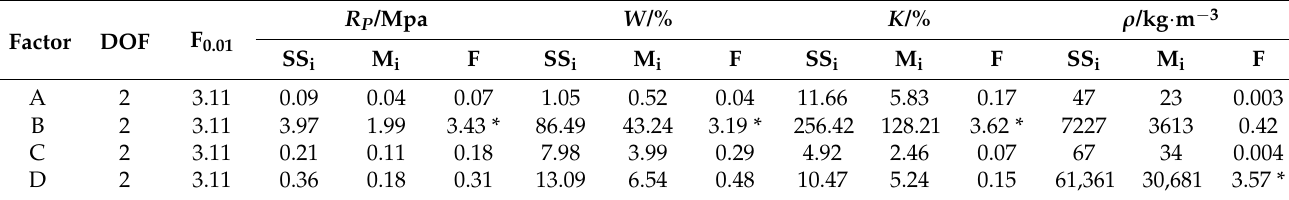
Table 4. Variance analysis of the orthogonal